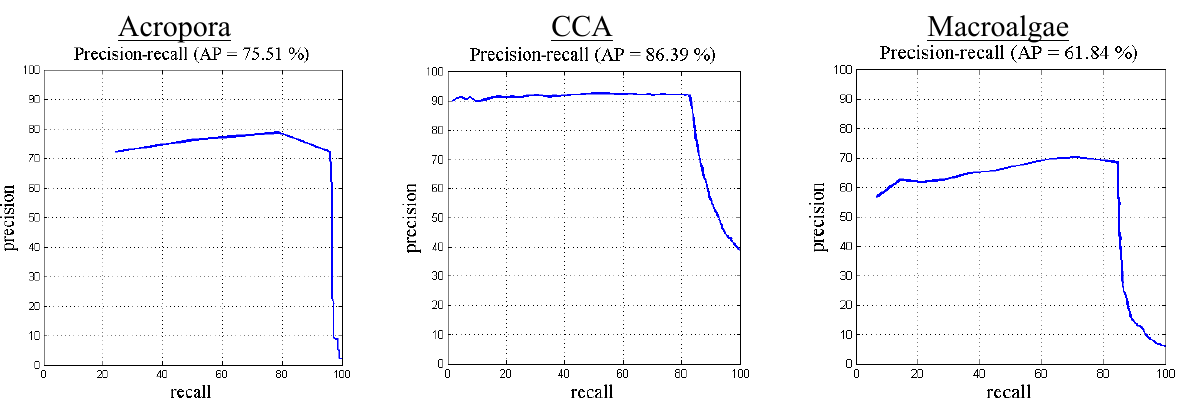
Figure 4. Precision-recall curve for individual classes of the MLC 2008 dataset using our method. Average precision for this dataset was 75.3%. The highest precision was observed for Pocillopora , and the lowest value was for the macroalgae class. Our method resulted in 85.5% overall accuracy. In the MLC 2008 dataset, the highest number of examples was from the CCA class, which also had frequent overlaps with other